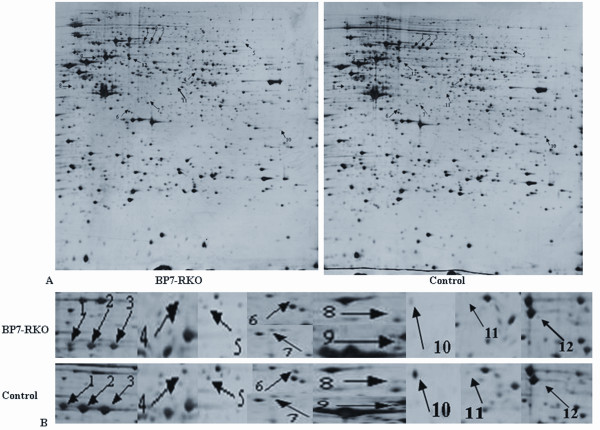
2D electrophoresis profiles of PcDNA3.1(IGFBP7)-RKO-transfectants and PcDNA3.1-RKO transfectants. A. 2D electrophoresis profiles of silver staining proteins of PcDNA3.1(IGFBP7)-RKO transfectants (BP7-RKO) and PcDNA3.1-RKO transfectants (control). 0.75 milligrams of protein were loaded onto linear IPG strips (pH 5-8) and isoelectric focusing was performed at 35 kV-h. The second dimensional run was performed on 12.5% Tris-glycine-PAGE gels and the gels were stained with silver for image analysis. Protein spot discrepancies were arrowed and marked with number. B. Close-up image of differential expression of protein spots.